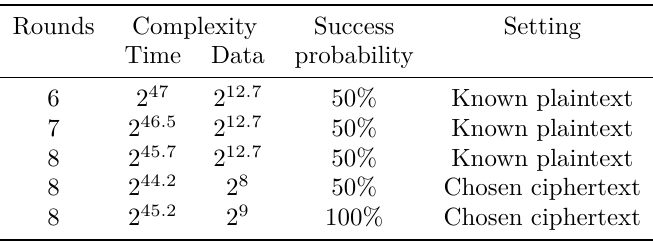
Table 1: Summary of attacks on SoDark presented in this